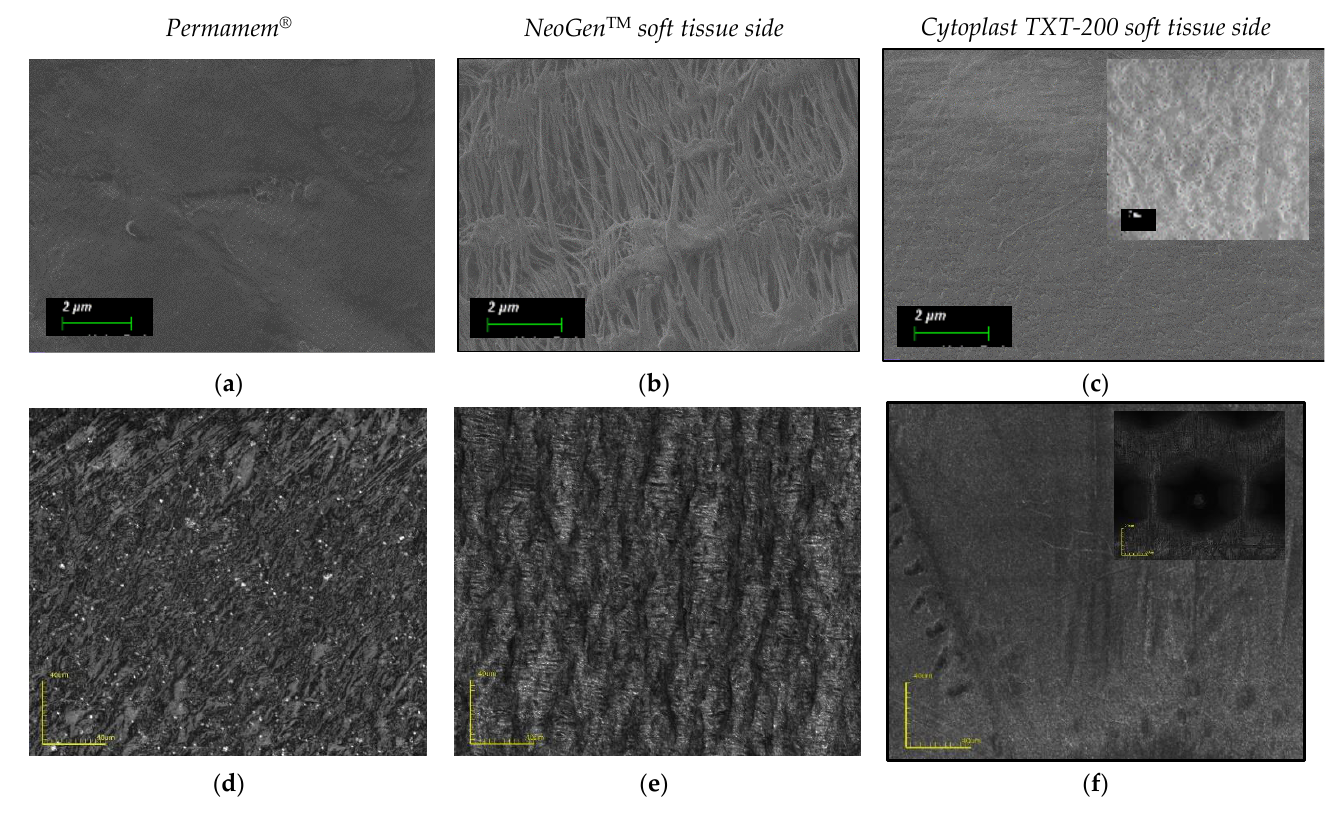
Figure 3. Nonresorbable polytetrafluoroethylene (PTFE) membranes SEM and CLSM images. Bar scale – 2 µm. ( a – c ) Please note the microfibril microstructure of the e-PTFE membrane (NeoGen TM ).